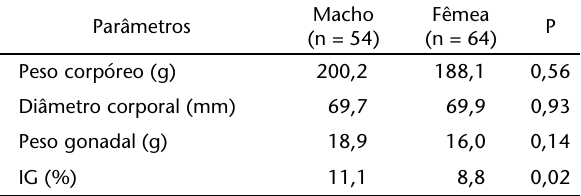
O IG foi significativamente maior nas luas crescente e cheia quando comparado com a lua minguante (Fig. 3). Na lua nova o IG não apresentou diferença significativa das demais luas. Os resultados de biometria entre machos e fêmeas não apresentaram diferenças significativas, entretanto o IG